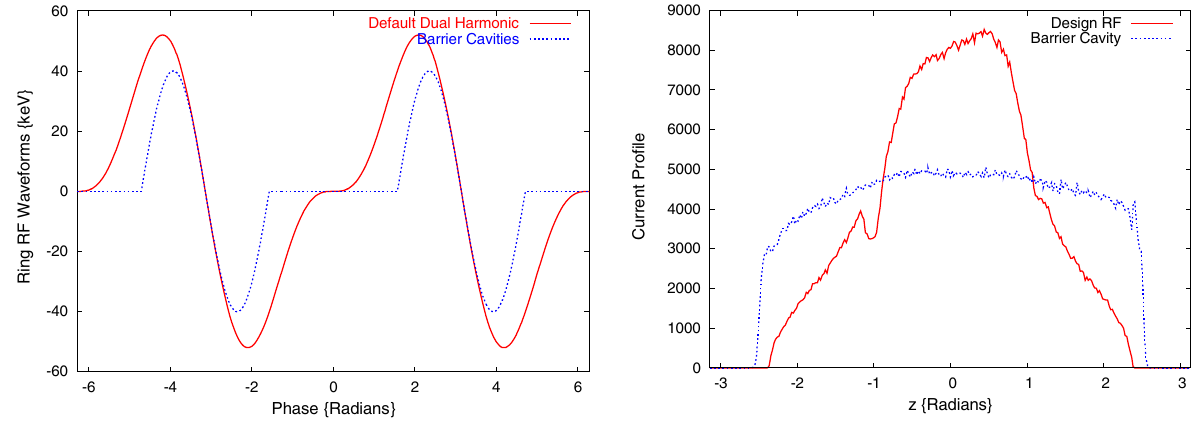
FIG. 3. (Left) Design dual harmonic and assumed barrier cavity waveforms plotted for two periods. (Right) Beam current profiles following accumulation for dual harmonic and barrier cavity rf waveforms. The bunch longitudinal coordinate z is normalized to the ring length divided by 2 π so that the full scale represents 248 m in these simulations.